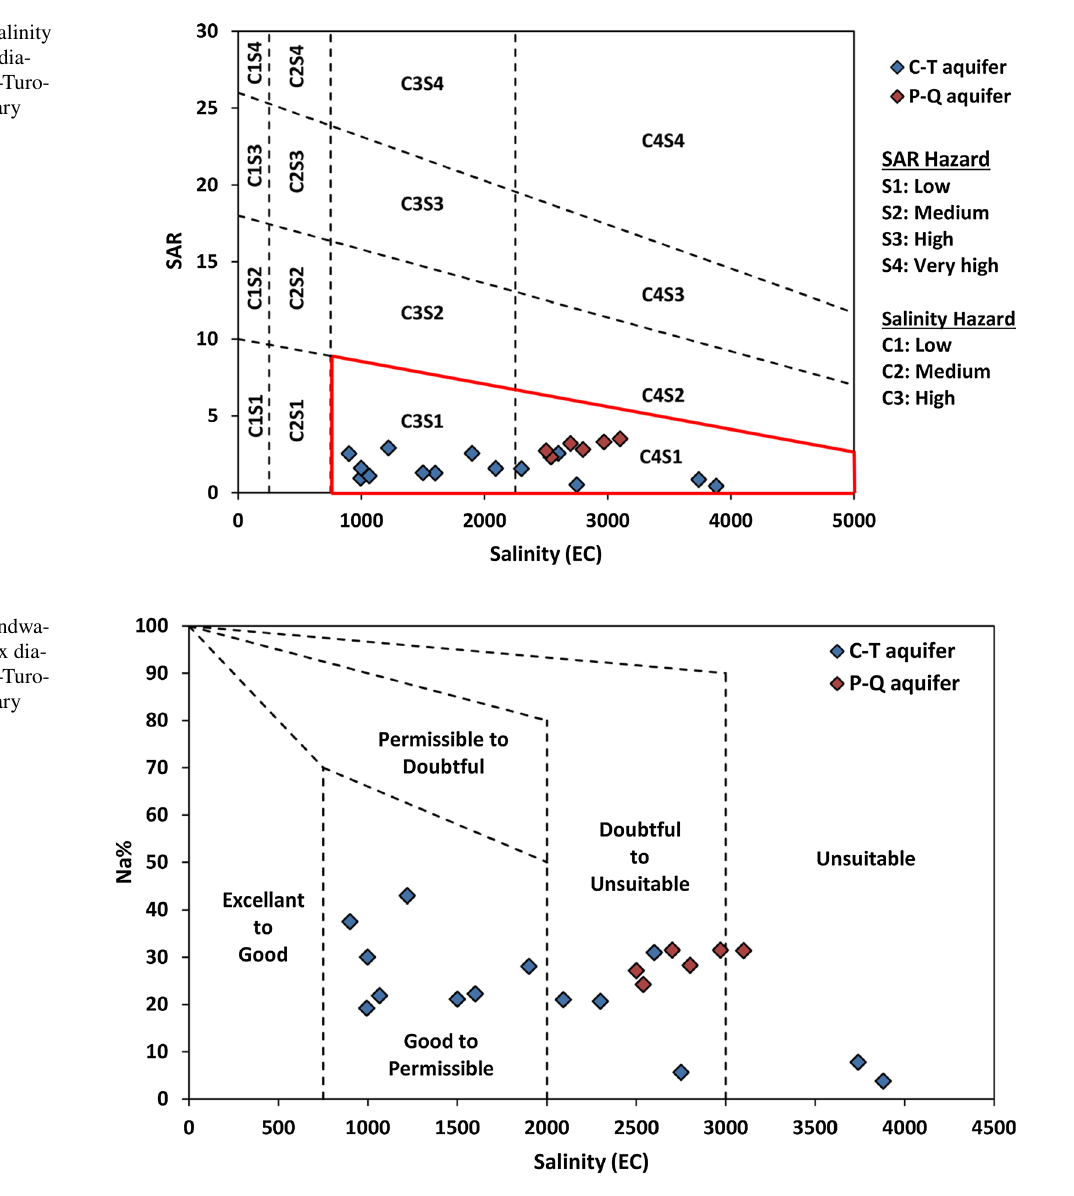
Fig. 8 Salinity versus alkalinity hazard in the US salinity dia- gram. C-T = Cenomanian-Turo- nian, P-Q = Plio-Quaternary